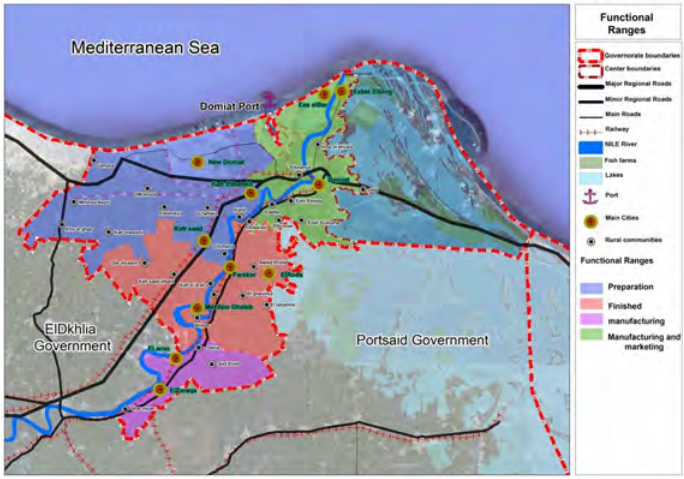
Figure 4. The functional specialization of furniture industry operations in Damietta Governorate